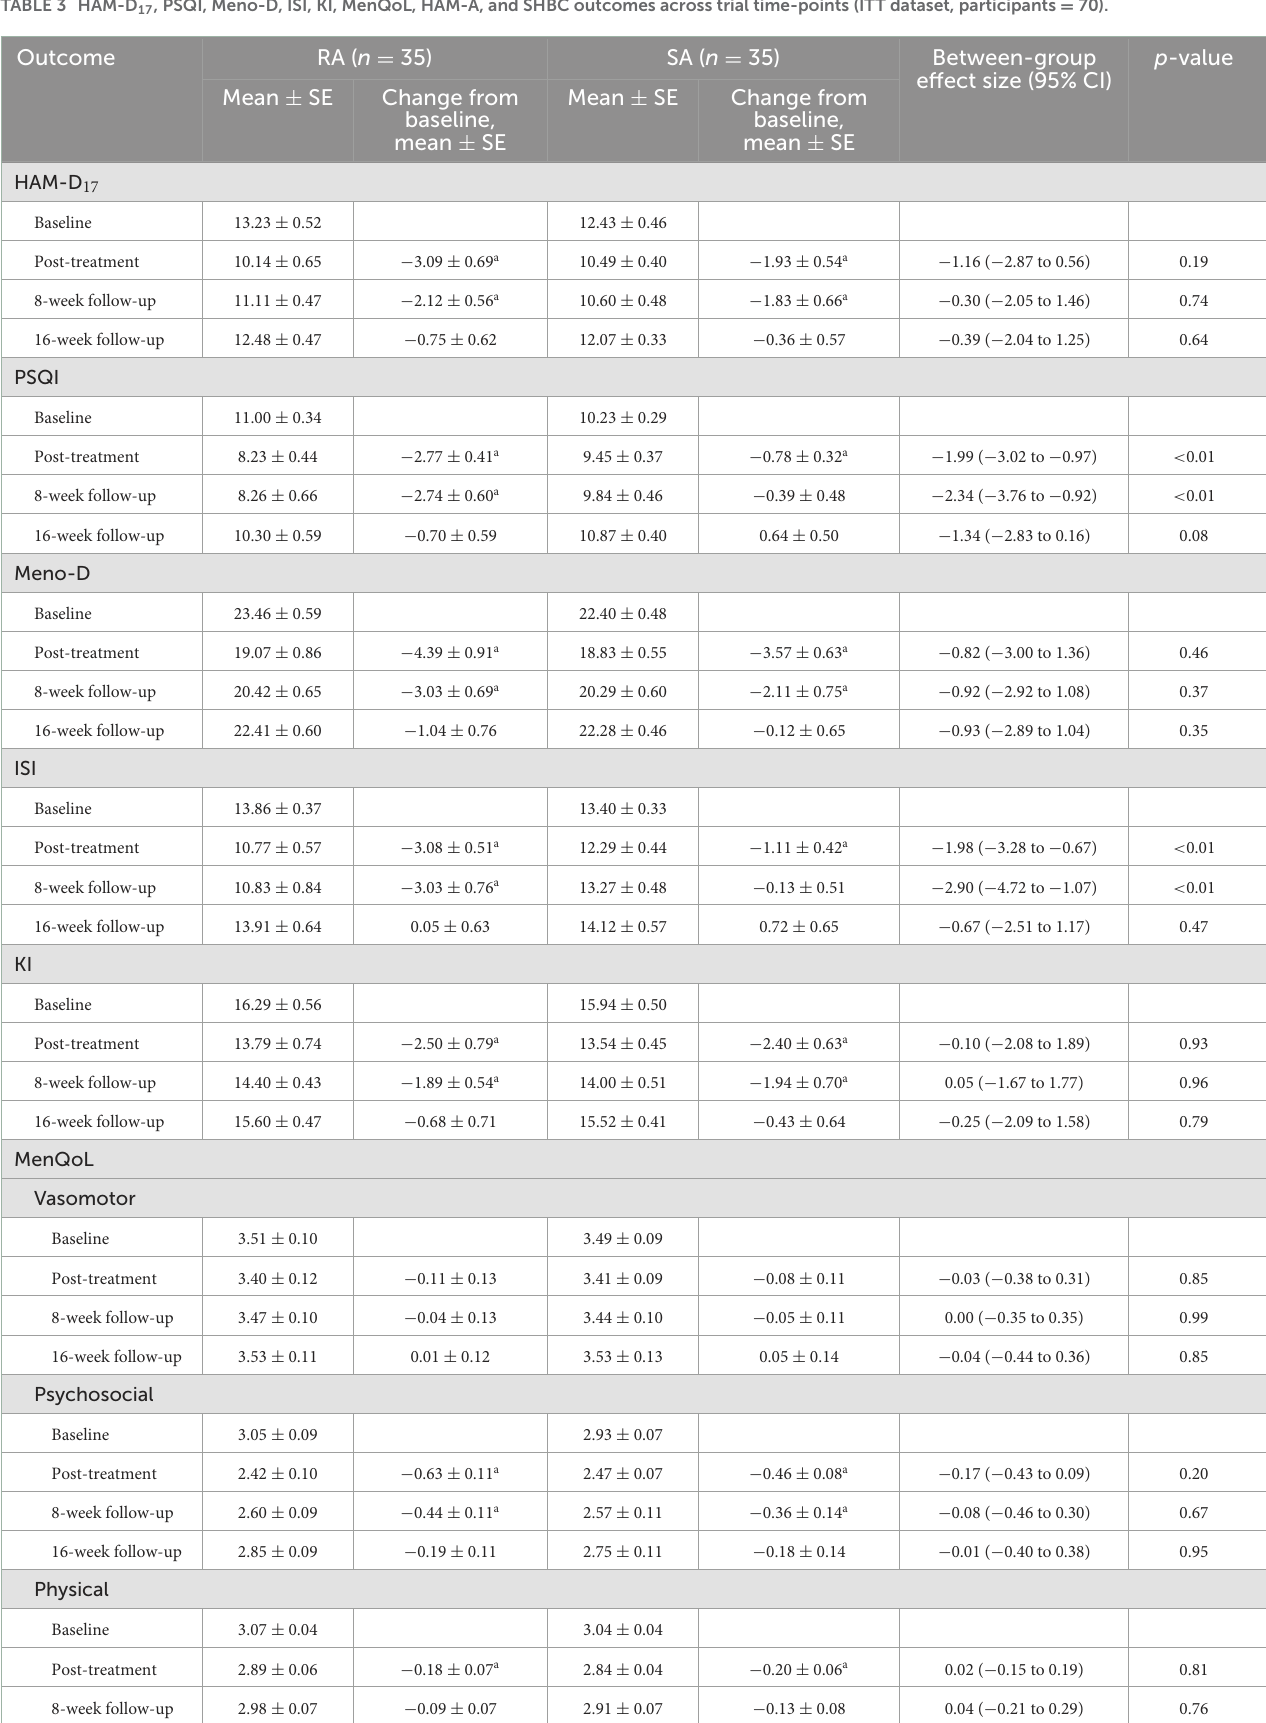
TABLE 3 HAM-D 17 , PSQI, Meno-D, ISI, KI, MenQoL, HAM-A, and SHBC outcomes across trial time-points (ITT dataset, participants = 70). Outcome RA ( n = 35) SA ( n = 35) Between-group